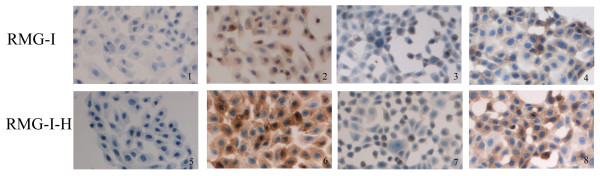
The expression of CD44 in RMG-I and RMG-I-H cells detected by immunocytochemistry (×400). Panels 1 and 5 are negative controls; panels 2 and 6 are Lewis y antibody-untreated cells; panels 3 and 7 are Lewis y antibody-treated cells; panels 4 and 8 are cells treated by irrelevant isotype-matched control. The expression of CD44 was detected by SABC methods in RMG-I and RMG-I-H cells, and brown color degree by DAB staining indicated the expression level of CD44. It can be seen from the figure that the expression of CD44 in the RMG-I-H cells was stronger than that in RMG-I cells, which was decreased after Lewis y antibody blocking.